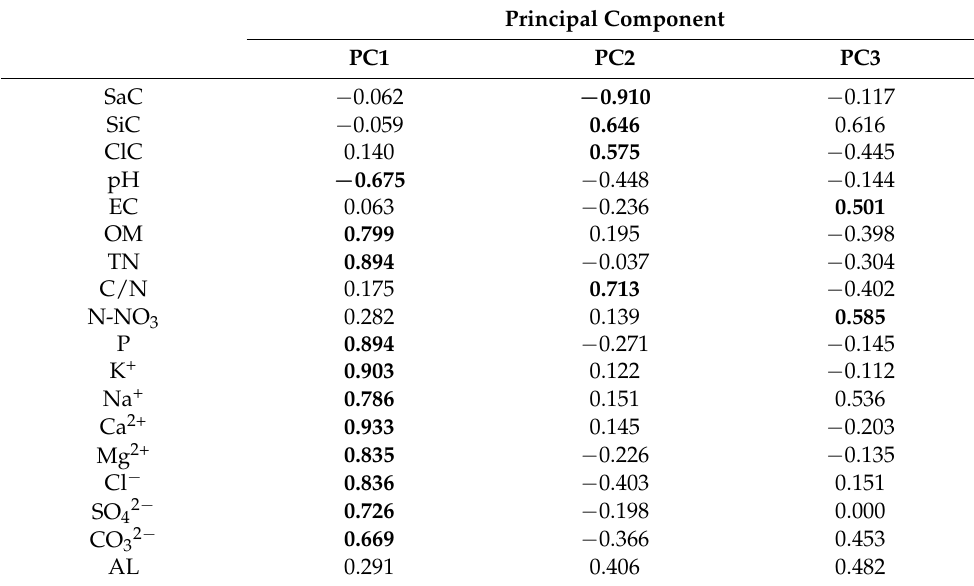
Table 1. Factor loadings of the original variables (main chemical properties of soils) on the first three Principal Components (PC1, PC2, and PC3) provided by PCA, applied to observations of the growth of Pinus halepensis Mill. in plots subjected to four treatments in the Sierra de Los Donceles forest (Li é tor, Castilla La Mancha, Spain). Legend: SaC = sand content; SiC = silt content; ClC = Clay content; EC = electrical conductivity; OM = organic matter; C = carbon; TN = total nitrogen; N-NO 3 = nitric nitrogen; P = phosphorous; K + = potassium; Na + = sodium; Ca 2+ = calcium; Mg 2+ = magnesium; Cl − = chloride; SO 42 − = sulphates; CO 32 − = carbonates; AL = active limestone. Principal Component PC1 PC2 PC3 SaC − 0.062 − 0.910 − 0.117 SiC − 0.059 0.646 0.616